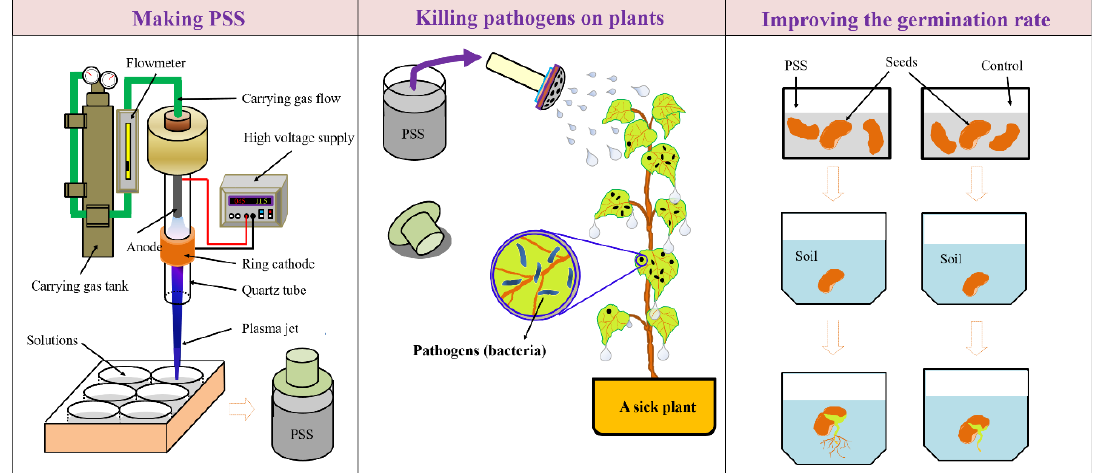
Figure 4. The application of CAP-stimulated solution (PSS) in agriculture. Here, PSS was made by the vertical treatment on solutions. Subsequently, the PSS containing 3-nitro-L-tyrosine can be stably stored in the container at 2 ◦ C to 8 ◦ C for at least a week. PSS can be used to kill the pathogens grown on the plant. In addition, the soak of seeds in PSS will improve the seed germination